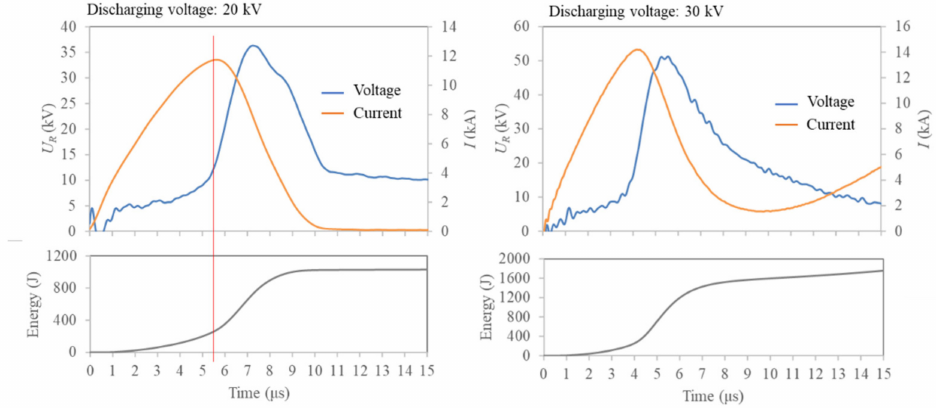
Figure 2. Profiles of discharge voltage, current, and energy injected into the graphite strip. The images of the explosion of the graphite strip, at a typical time for a discharge voltage of 20 kV, is shown in Figure 3. The expansion of the graphite strips began im- mediately after the start of the discharge. The graphite strips contain a large amount of nitrogen gas. The electrical energy injected into the graphite strip was not sufficient to achieve a change in the state of the graphite strip. Therefore, the expansion of the strip was due to the thermal expansion of the gas. In the image taken 2.39 µ s after the start of the discharge, numerous small arc-shaped shock waves are observed. This indicates that the gas inside the sample was rapidly heated, resulting in expansion and explosion. The black expansion zone blocked the light transmitted from the laser. When the electrical resistance started to increase, light emission was observed in the black expansion band (5.29 µ s). When the nitrogen atom recombines, it transitions from the higher energy level B 3 Π g to the lower level A 3 Σ u. This is a molecule-to-molecule transition, and the light emission spectrum is band-like (500–800 nm) [40]. It is to be noted that this wavelength region covers the band-pass filter attached to the camera lens. In other words, the light- emission region in the image shows nitrogen molecules in the transition process. In the image captured at 9.09 µ s, when the energy injection was completed, the current path was observed to be occupied by nitrogen molecules. The increase in electrical resistivity can be attributed to the removal of conductive graphite from the current path. In the image captured at 11.29 µ s, interference fringes of transmitted light (laser light) and shock waves are observed around the expanding gas, and the region of transmitted light is enlarged at 13.99 µ s. As the transparency of water as a medium increases, the laser light is transmit- ted. Therefore, we can conclude that the black expansion band corresponds to exfoliated single-or few-layer graphene. A similar phenomenon was observed at an earlier time for a discharge voltage of 30 kV. We believe that the recovery of graphene increases under higher voltage conditions because the gas inside the sample can be heated and exploded more quickly. In fact, in our previous studies, the recovery of thin graphene was higher under high-voltage conditions [30]. The videos of explosion at each condition are provided in the Supplementary Materials (Videos S1 and